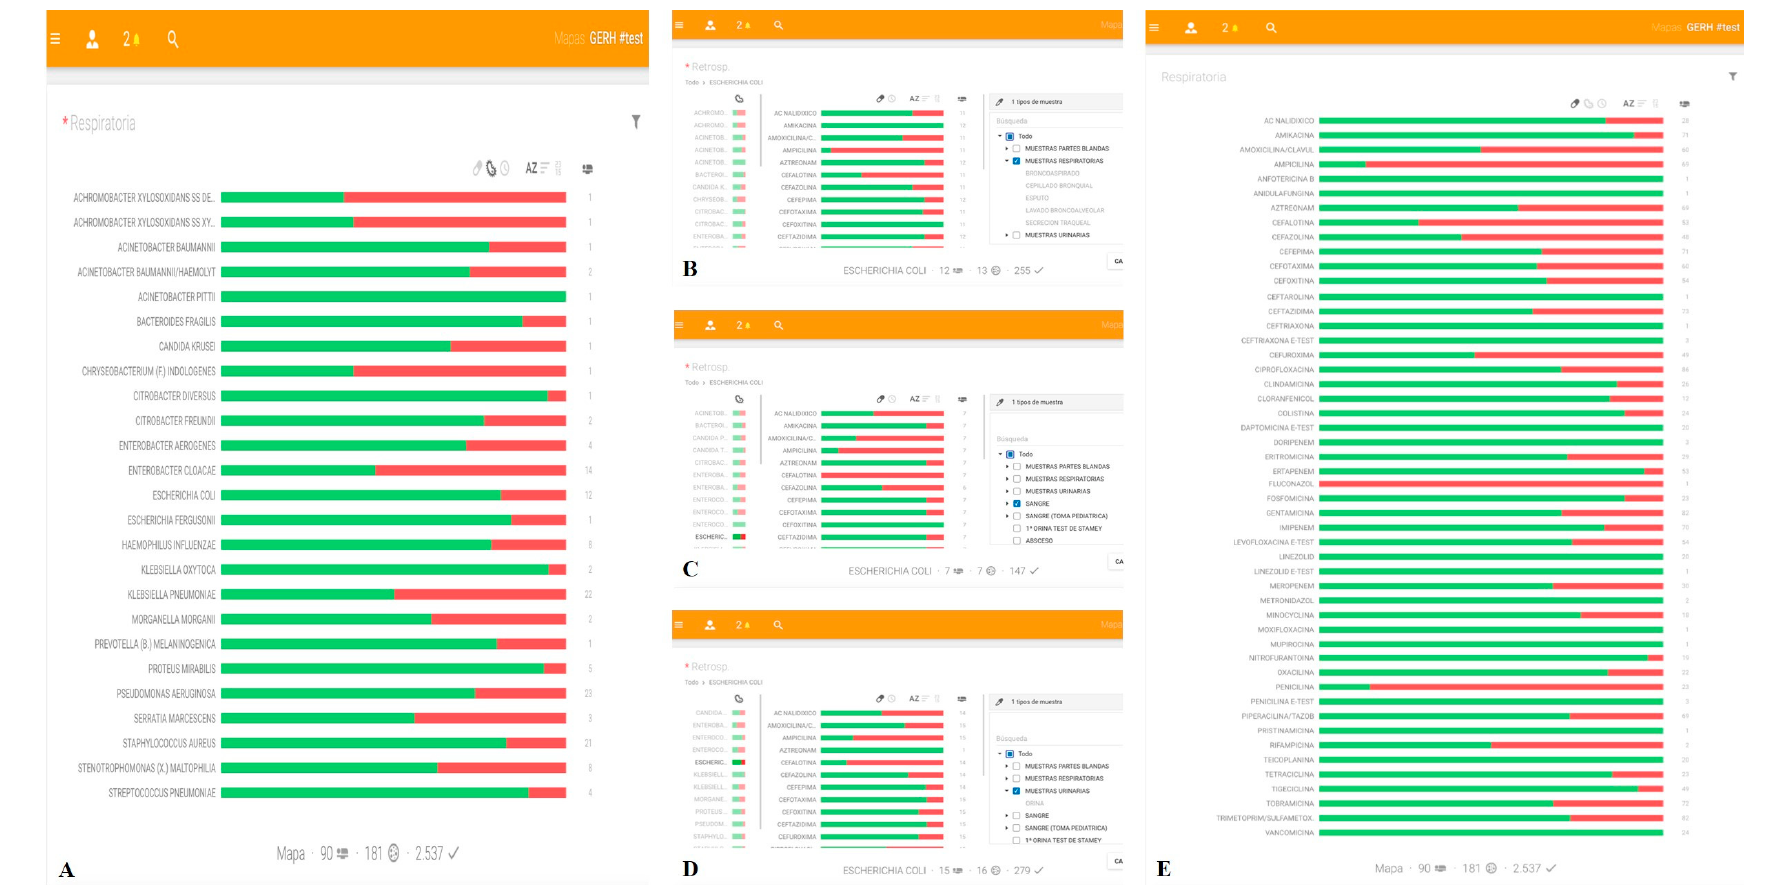
Figure 1. GERH ® -derived local resistance maps (LRMs). The search criteria in LRMs offer different types of graph. As an example, this figure depicts the following: ( A ) graph showing the frequency of isolation of each bacterial species in ICU patients with lower respiratory tract infection between 1 January and 31 December 2015 alongside the accumulated susceptibility; ( B ) graph showing the accumulated susceptibility of E. coli in isolates obtained in respiratory samples (bronchial aspirate, bronchial brushing, sputum, bronchoalveolar lavage or tracheal secretion) of ICU patients between 1 January and 31 December 2015; ( C ) graph showing the accumulated susceptibility of E. coli in isolates obtained in blood samples of ICU patients between 1 January and 31 December 2015; ( D ) graph